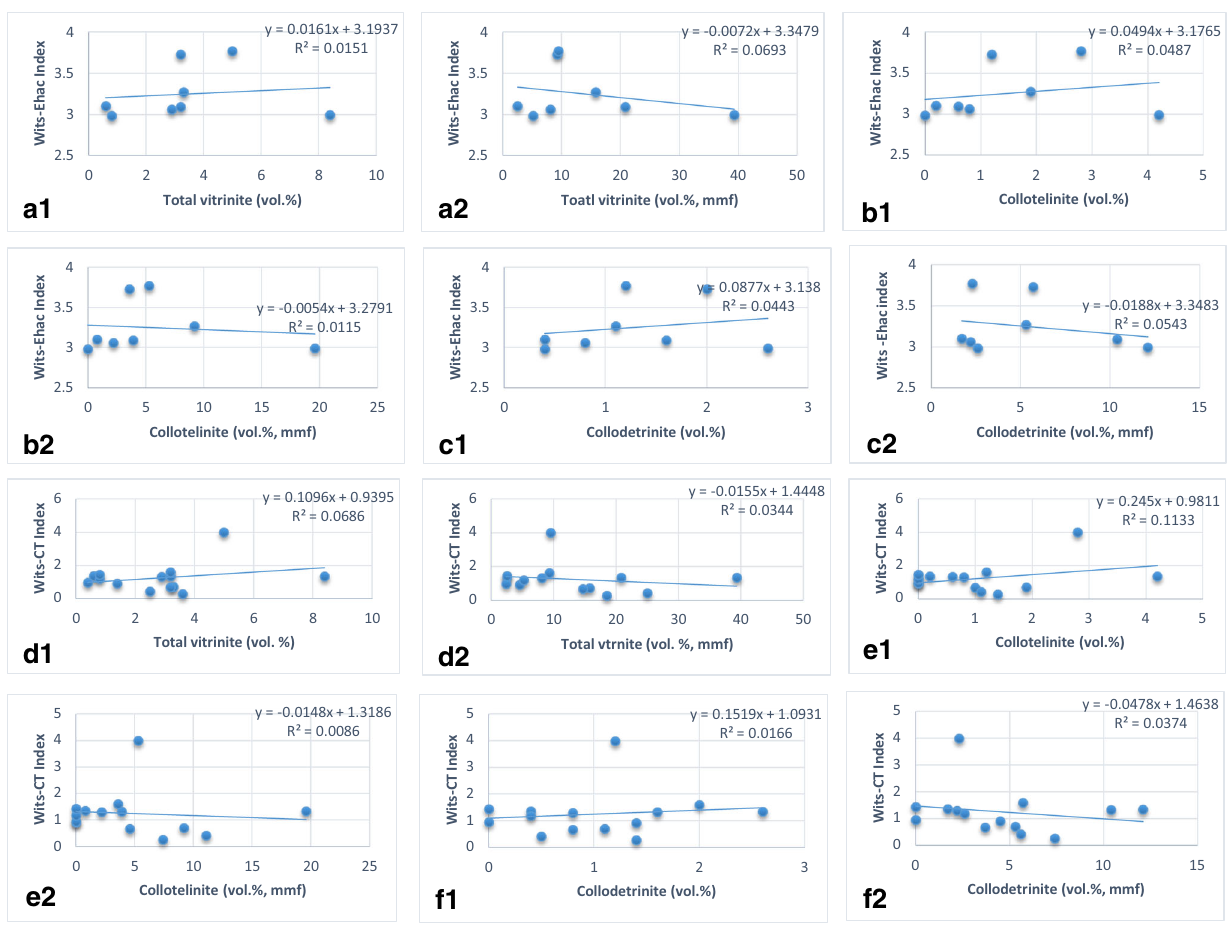
Fig. 8 Influence of vitrinite and its group on spontaneous combustion of